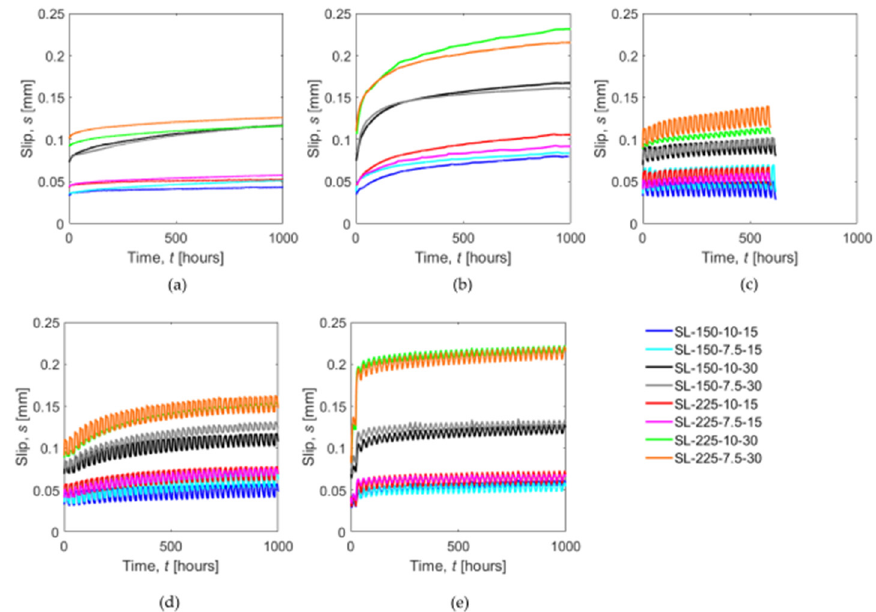
Figure 4. Slip at the loaded end obtained in series ( a ) S1; ( b ) S2; ( c ) S3 ‐ A; ( d ) S3 ‐ B; ( e )